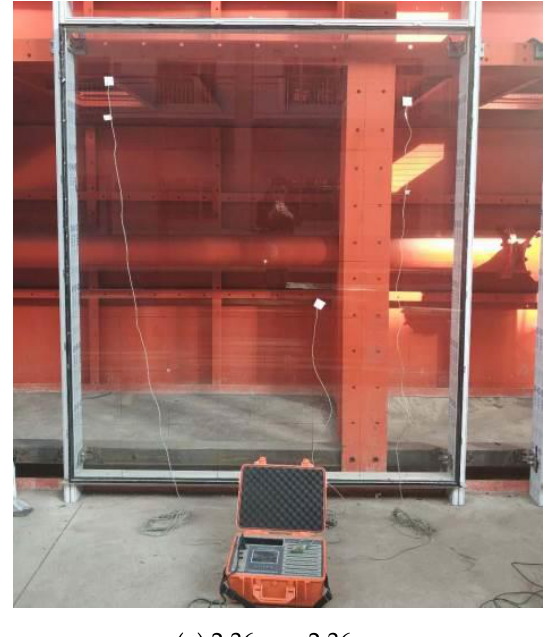
Figure 2. Photo of test specimen.